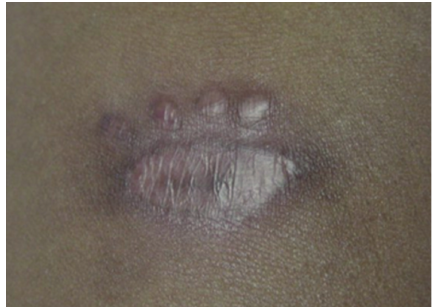
Figure 4: Scar in the forearm 40 days after the initiation of